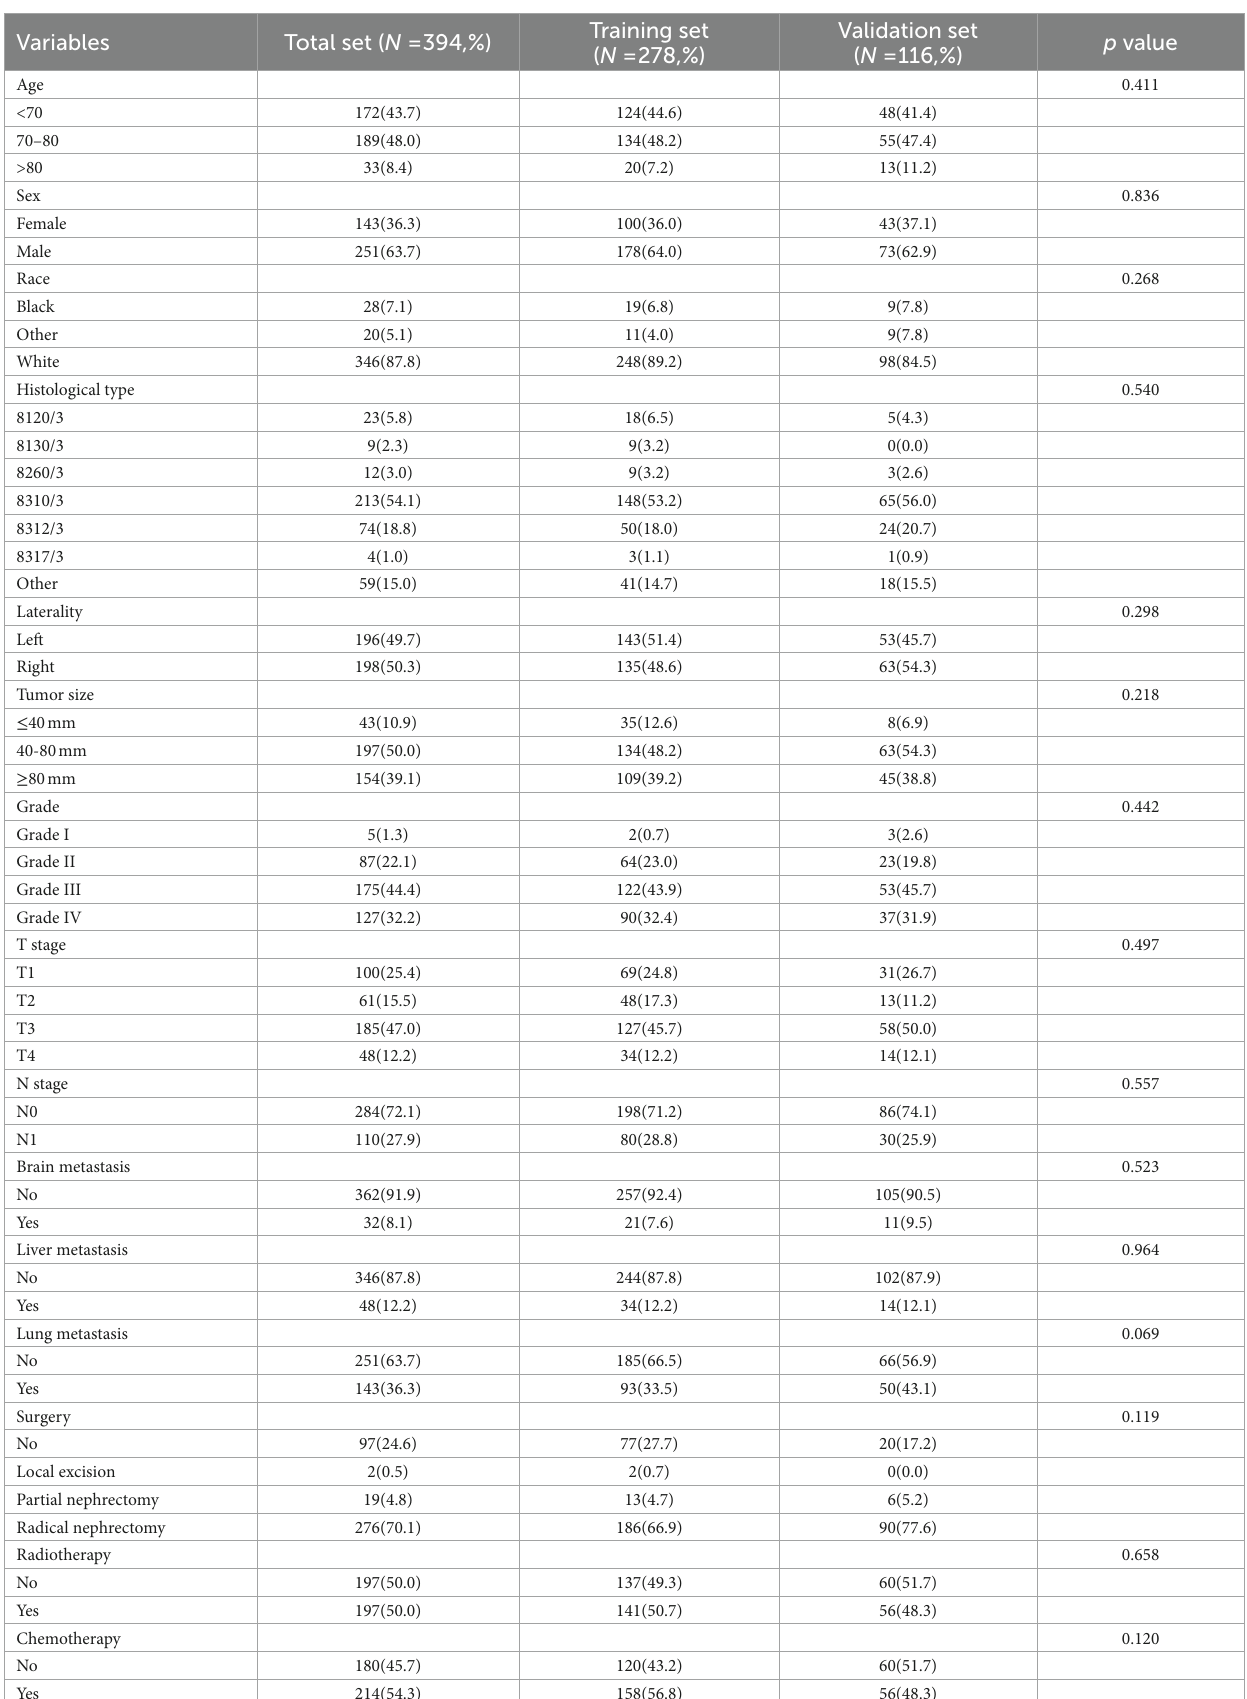
TABLE 3 The demographic and clinicopathological characteristics of elderly KC patients with BM.